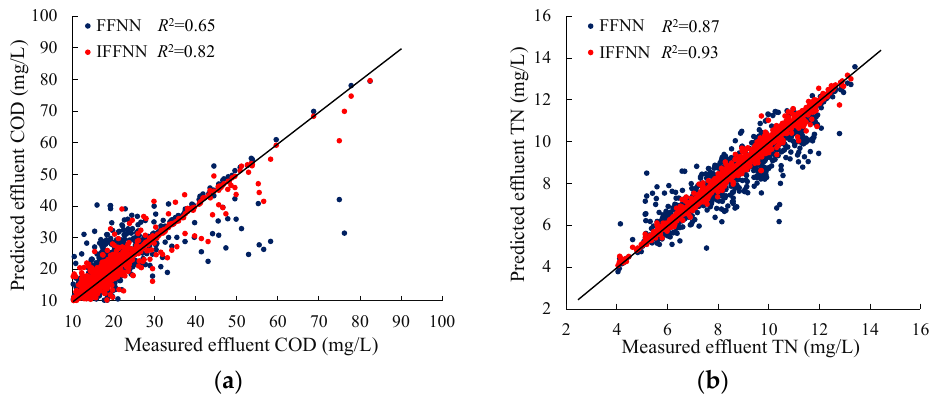
Figure 5. Comparison of modeling performance efficiency between FFNN and IFFNN for the water quality indicators ( a ) COD and ( b ) TN, respectively.